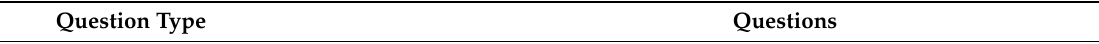
Table 2. List of interview